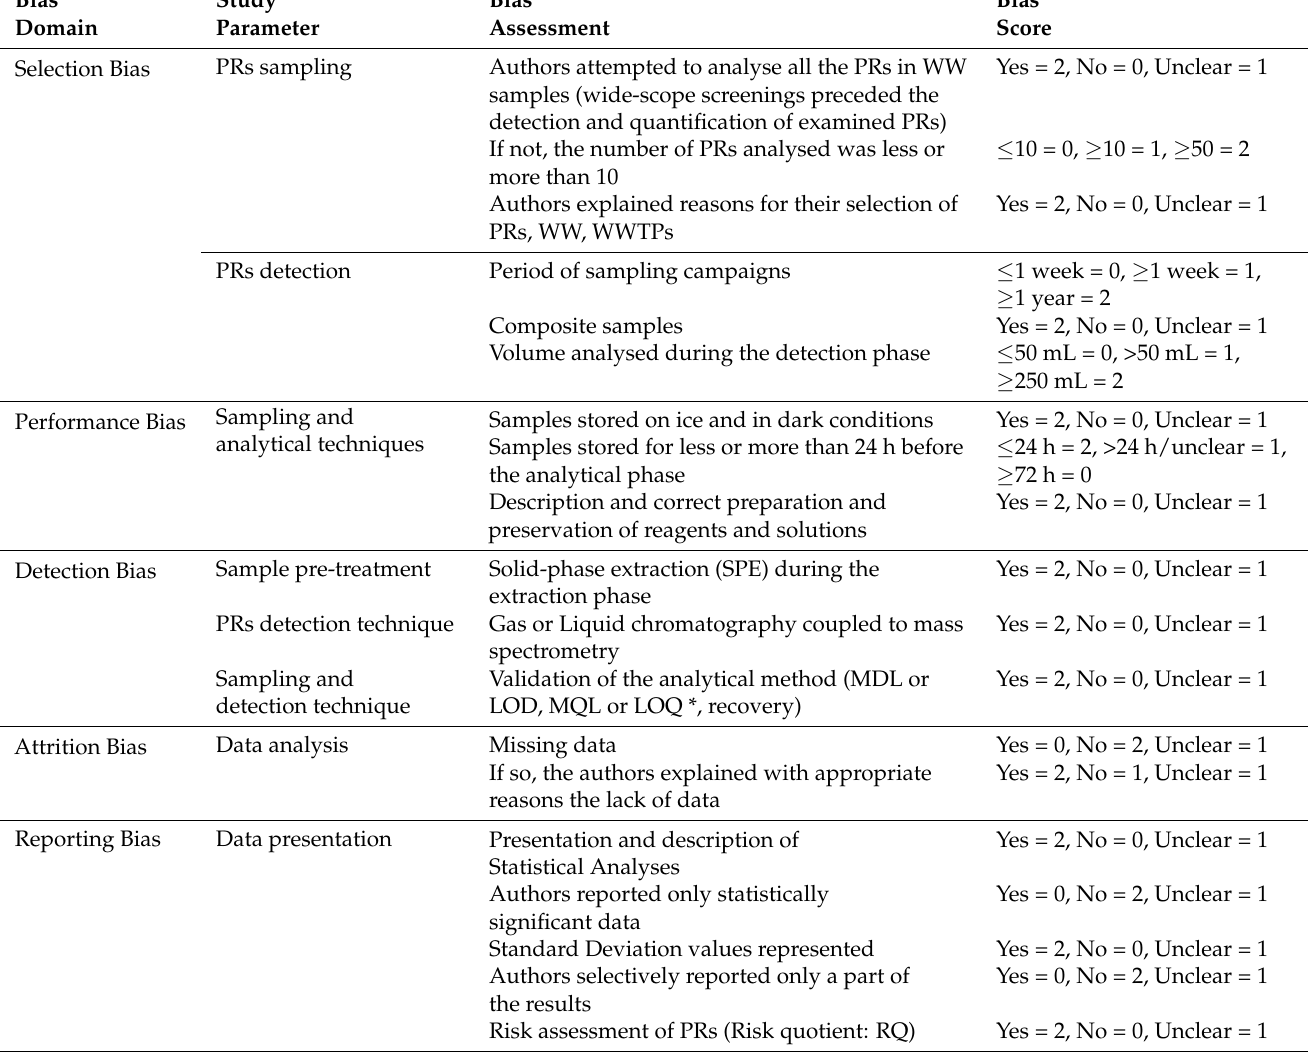
Table 1. Pre-set list of bias assessment for internal and external